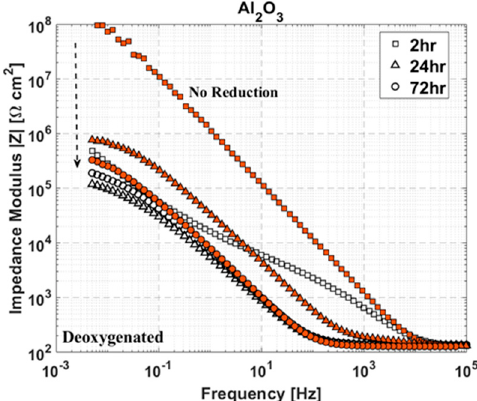
Figure 12. Impedance modulus versus frequency at selected immersion times over 72 h in deoxygenated 0.1 M NaCl for ALD Al 2 O 3 on copper. Unfilled shapes (black) are with and filled shapes (red) are without an initial 2.5-min reduction at − 1.5 V. Dashed arrow points in the direction of increasing immersion time.